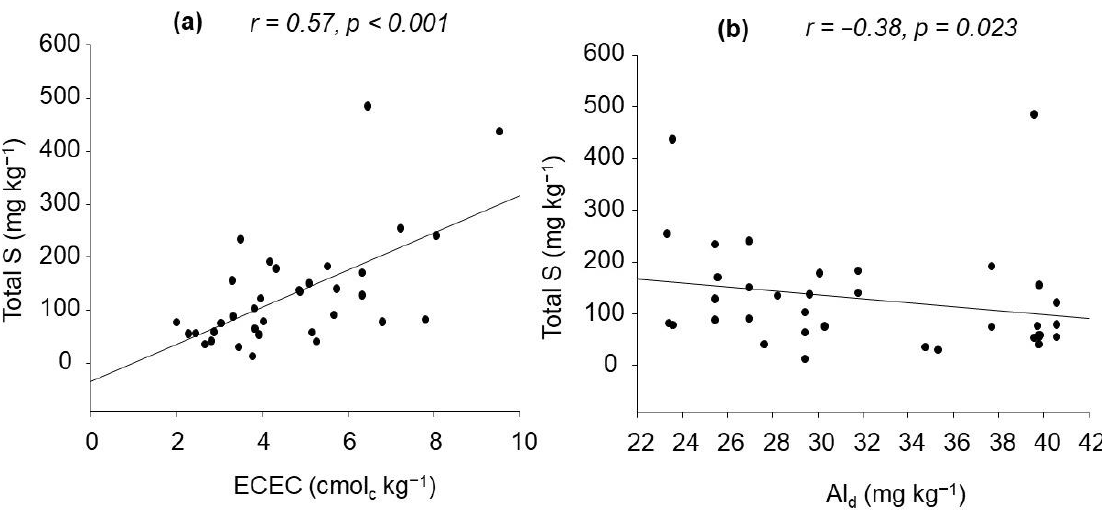
Figure 4. Spearman correlations, showing a positive correlation between Dompem total S and ( a ) ECEC and a negative correlation with ( b ) Al d.